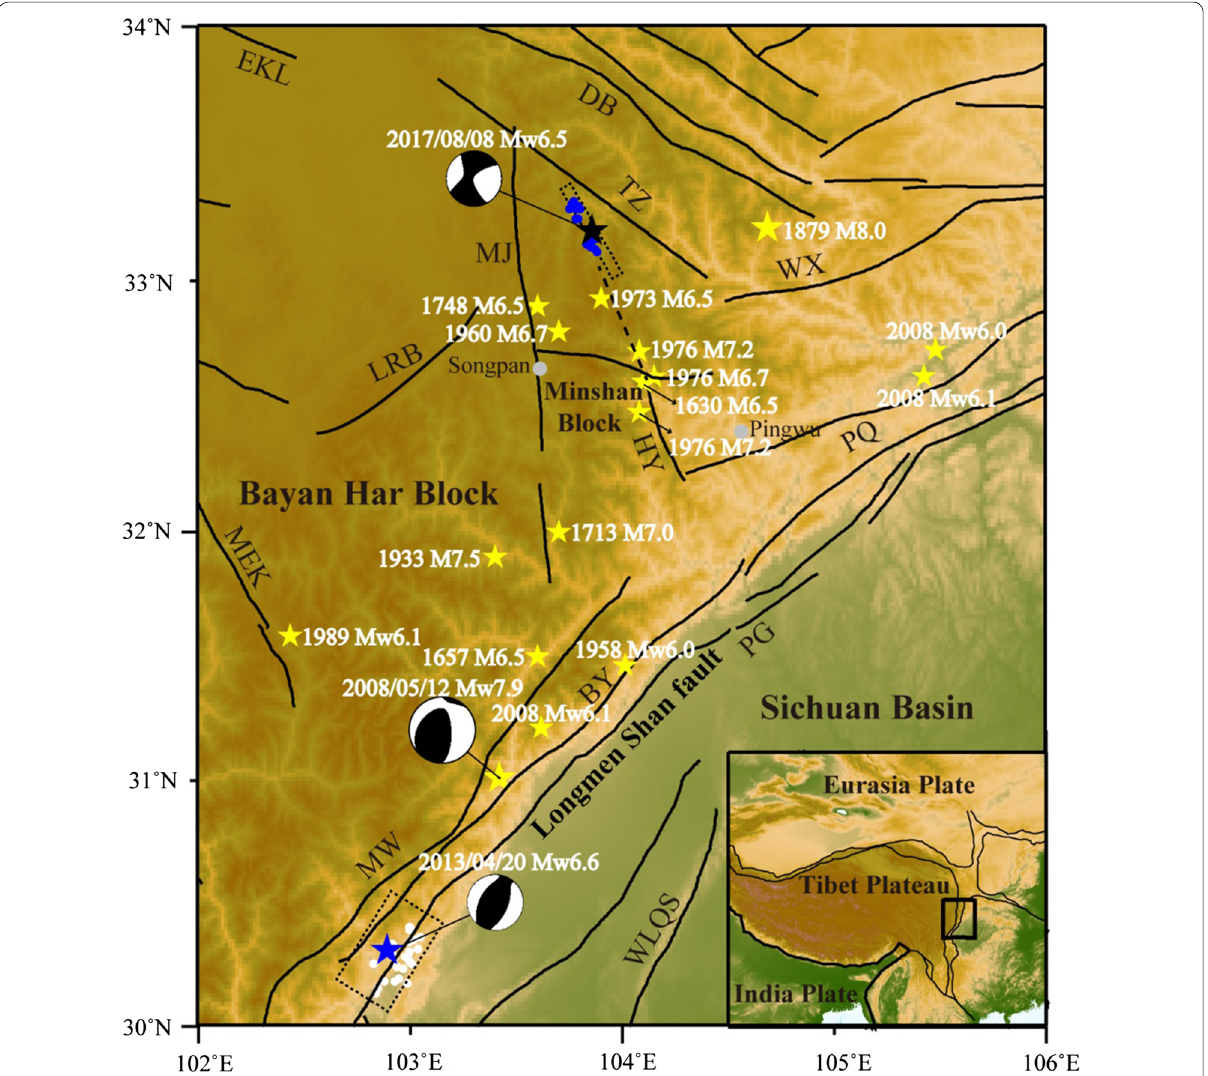
Fig. 1 Tectonic settings of the eastern margin of the Tibet Plateau region. Black star, blue star and yellow stars represent the epicenters of the 2017 Jiuzhaigou earthquake, 2013 Lushan earthquake and historical earthquakes, respectively. The blue circles are the 2017 Jiuzhaigou earthquake 1 day M L > 3 aftershocks, and white circles denote the 2013 Lushan earthquake 1 day M L > 4 aftershocks. The black dash boxes indicate the surface projection of the fault planes used in this study. Focal mechanisms of the 2008 Wenchuan, 2017 Jiuzhaigou and 2013 Lushan earthquakes are also plotted (http://www.globa lcmt.org/CMTse arch.html). The inset shows the local tectonic setting. The black lines indicate the major active faults in this region according to Deng et al. (2003a): BY (Beichuan-Yinxiu), DB (Diebu-Bailongjiang), EKL (East Kunlun), HY (Huya), LMS (Longmen Shan), LRB (Longriba), MEK (Maerkang), MJ (Minjiang), MW (Maowen-Wenchuan), PG (Pengxian-Guanxian), PQ (Pingwu-Qingchuan), TZ (Tazang), WLQS (West-Longquanshan) and WX (Wenxian) faults. Location parameters of historical earthquakes are based on the previous studies (Jones et al. 1984; Department of Earthquake Disaster Prevention, China Earthquake Adiministration 1995, 1999; USGS, https ://earth quake .usgs.gov/). The thin black lines in the inset map of Fig. 1 are boundaries of first-level blocks in mainland China, and the bold black lines 1 are boundaries of